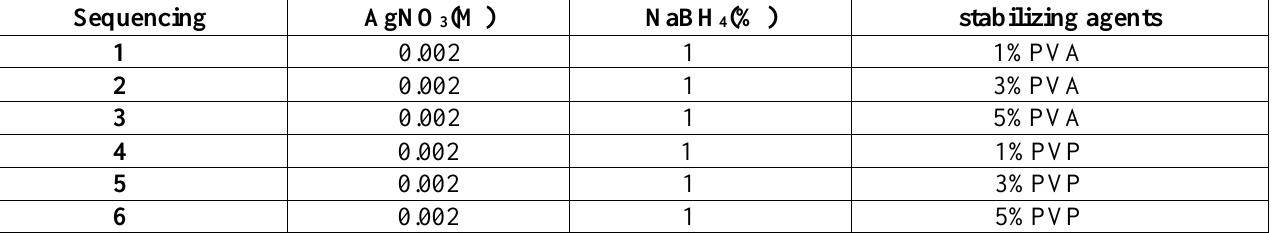
Table 1: Silver nitrate and sodium borohydride concentrations with stabilizing agents (PVP,